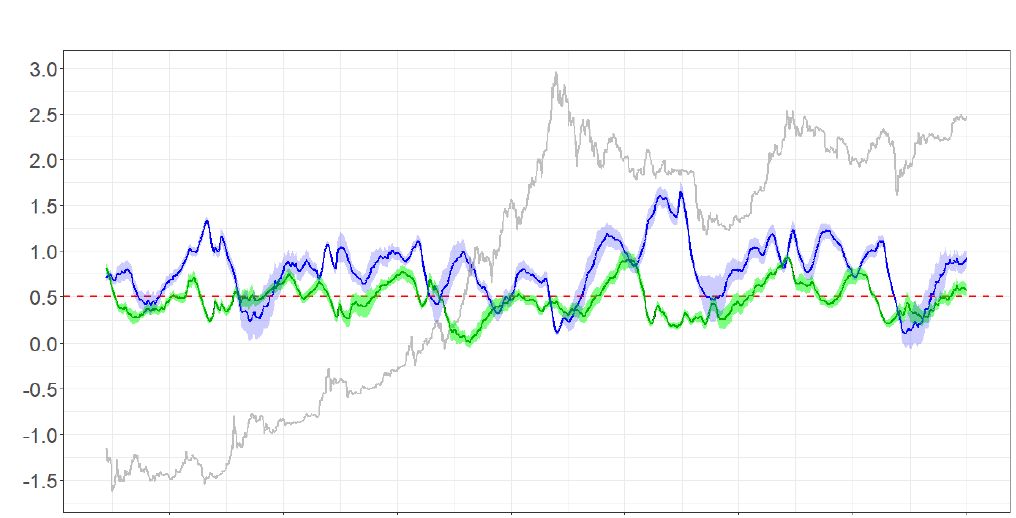
Figure 4. DFA exponent time evolution. The plot exhibits the DFA exponent (Peng et al. 1994, 1995) for returns (in green) and volatility (in blue). Estimates consider sliding windows of 250 daily observations and one datapoint step forward. The shadow area refers to the standard error of the corresponding coefficient. The log of Bitcoin prices (divided by 10 3 ) is reported in gray. The dotted red line stands for the 0.5 level of the DFA α